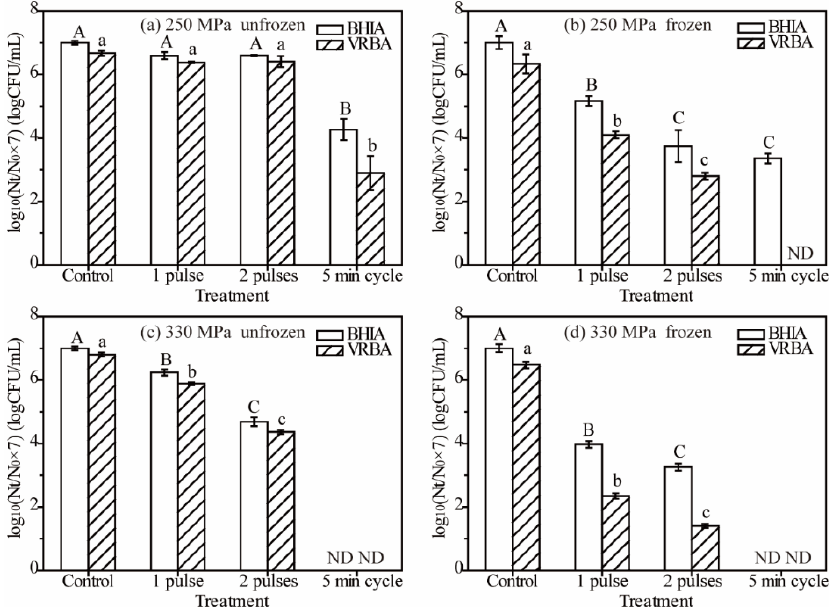
Figure 2. The E. coli survivors on both BHIA and VRBA plates in unfrozen and frozen culture suspensions after different HP treatments (250 MPa (( a ) unfrozen, ( b ) frozen), 330 MPa (( c ) unfrozen, ( d ) frozen)) and different pulses. Different letters (A, B, C, and D or a, b, c, and d) indicate a significant difference ( p < 0.05) (when the same letter shares—not significant p > 0.05) between treatments on the same enumeration medium. ND means not detected. Mean values ± standard error ( n =